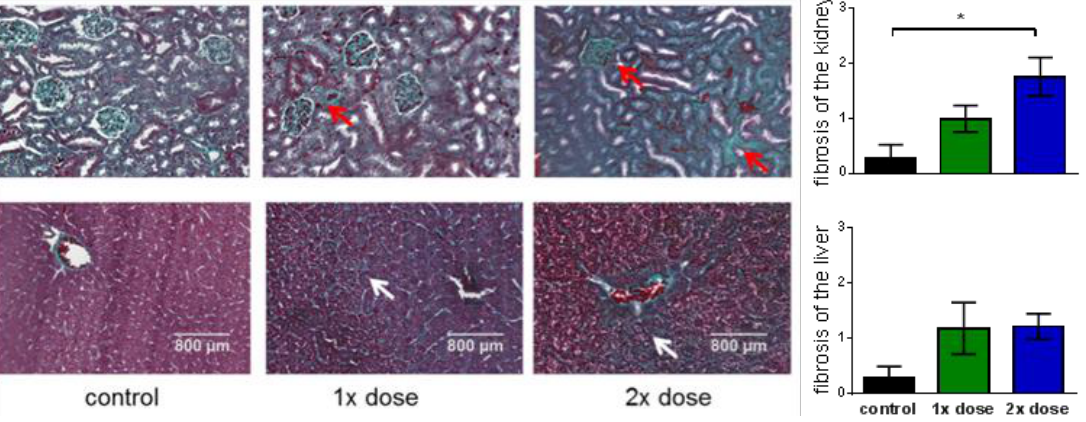
Figure 6. Histological examinations of kidney ( upper row ) and liver ( lower row